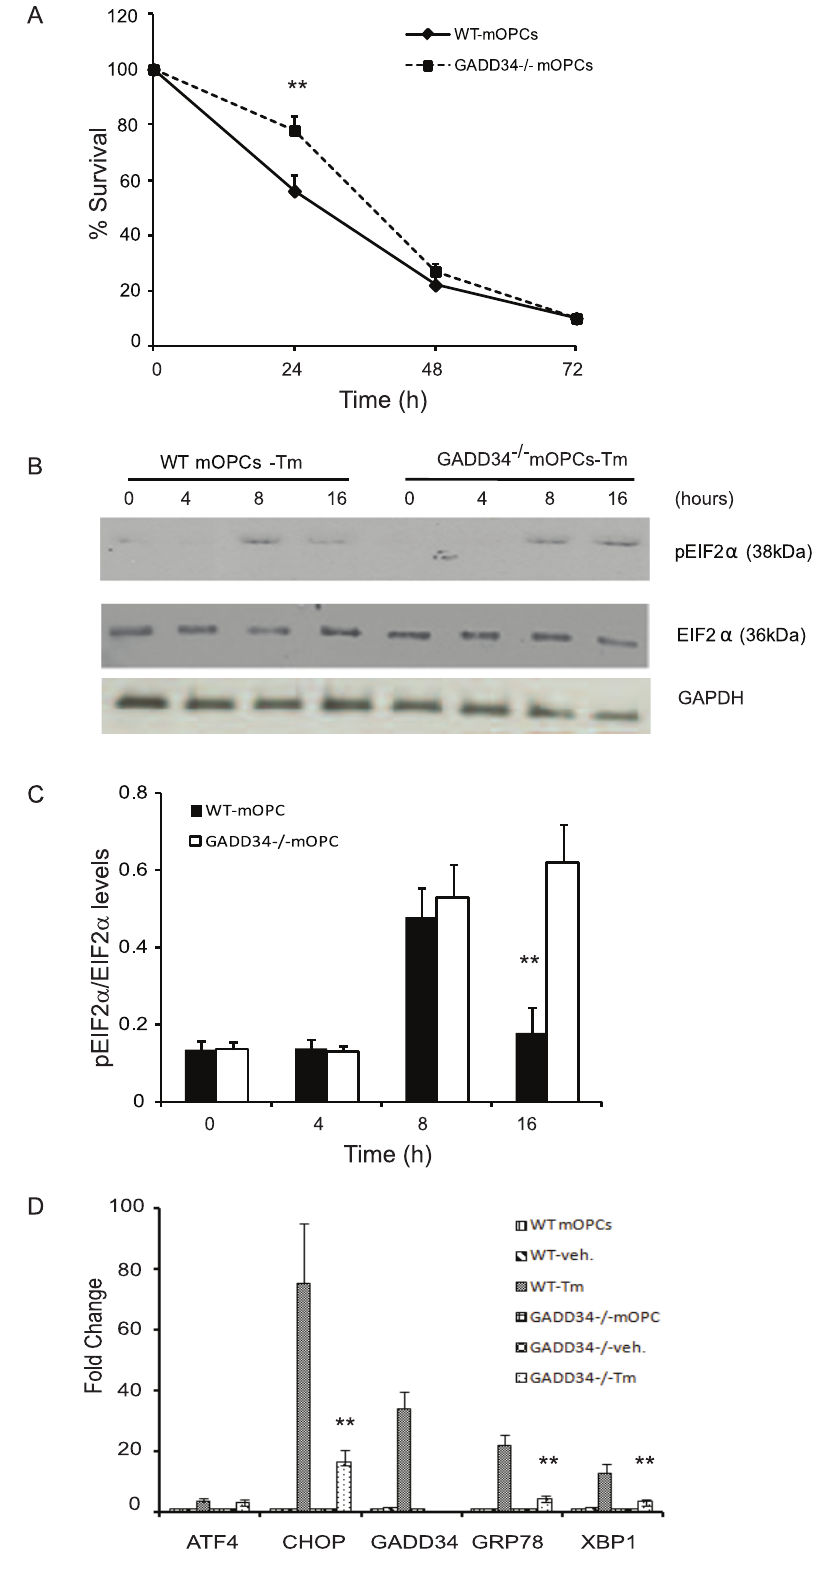
Figure 1. GADD34 -/- mOPCS show enhanced survival in response to ER stress. (A) Quantification using MTT assay show increased survival of GADD34 -/- mOPCs exposed to tunicamycin (Tm; 0.01 m g/ml) at only 24 hours. (B,C) Western blot shows sustained translational repression in GADD34 -/- mOPCs in contrast to WT mOPCs. (D) RT-PCR data shows attenuation in the ERSR in GADD34 -/- mOPCs exposed to Tm for 16 hours. Data (A,C,D) are the mean 6 SD (n=4, ** p , 0.01). doi:10.1371/journal.pone.0109703.g001 PLOS ONE | www.plosone.org